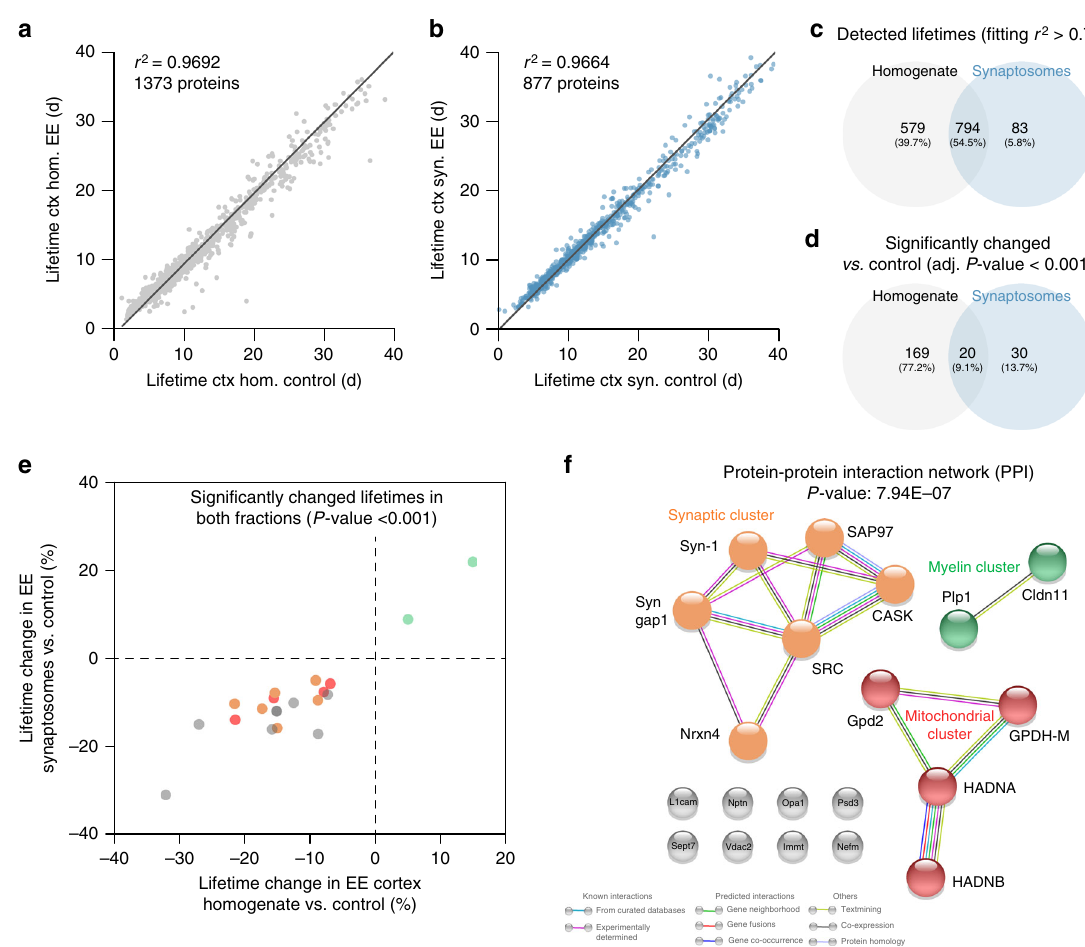
Fig. 7 Protein lifetime differences upon chronic environmental enrichment. a , b Scatter plots of protein lifetimes upon prolonged environmental enrichment in the cortex homogenate ( a ) or in the cortex synaptosomes ( b ) vs. the control mice. c Among the proteins whose lifetime have been precisely determined, there are 794 common hits. d Some of the proteins are signi fi cantly different (Bonferroni adjusted P -value < 0.001), and of these only 20 are common among the two cellular fractions. e A precise analysis of these proteins identi fi es synaptic components that are turned over at a higher speed following environmental enrichment, such as the presynaptic adhesion molecule Neurexin-4, the scaffold molecule CASK, the phosphoprotein synapsin-1 and the neuronal RasGAP SynGAP1 (see Supplementary Table 2 for details). Some mitochondrial components implicated in the metabolism of glutamate and acetyl-CoA are also turned over at a higher speed following environmental enrichment (Supplementary Table 2). On the contrary, two myelin components (PLP1 and Claudin 11) are stabilized upon environmental enrichment (Supplementary Table 2). f String analysis of the 20 common proteins. This identi fi es three functional protein clusters changed upon environmental enrichment (Supplementary Table 2). The detailed analysis indicates that the most important differences between these two cohorts of mice are at the level of myelin, the mitochondrial inner membrane and